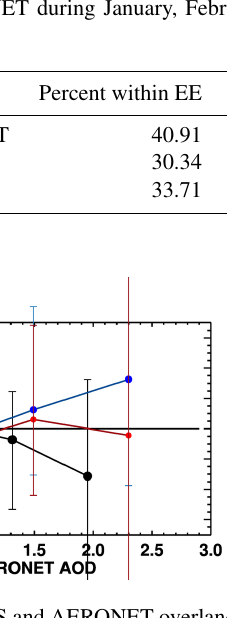
Figure 10. Bias between MODIS and AERONET overland AOD at 0.55µm as a function of AERONET AOD at 0.55µm. Black rep- resents the operational DT AOD, blue represents the AOD using the operational LUT but with new masks, and red represents the re- search AOD. The dots are the mean bias within each AERONET AOD bin, and the bars represent the standard deviation of the bias.